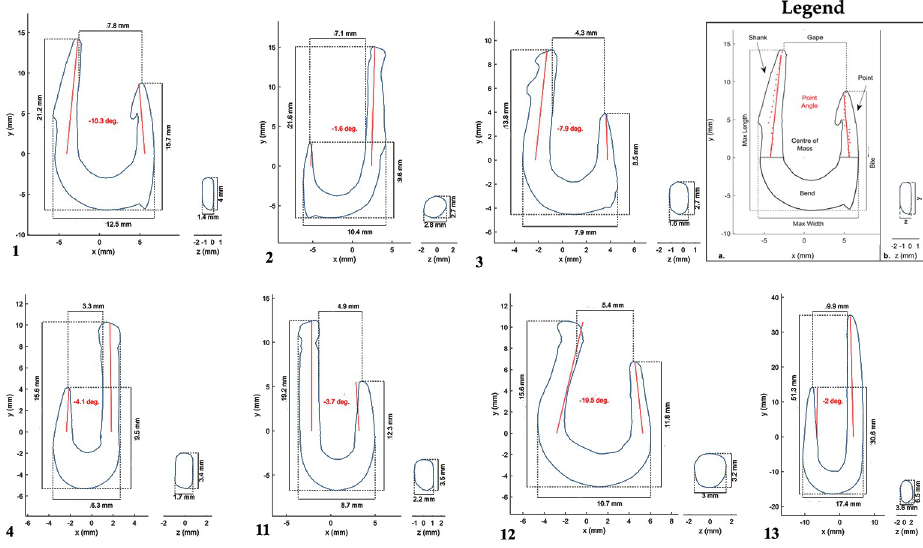
Fig 6. Measurements extracted based on the profile (legend a) and the cross-section (legend b) of the hooks.